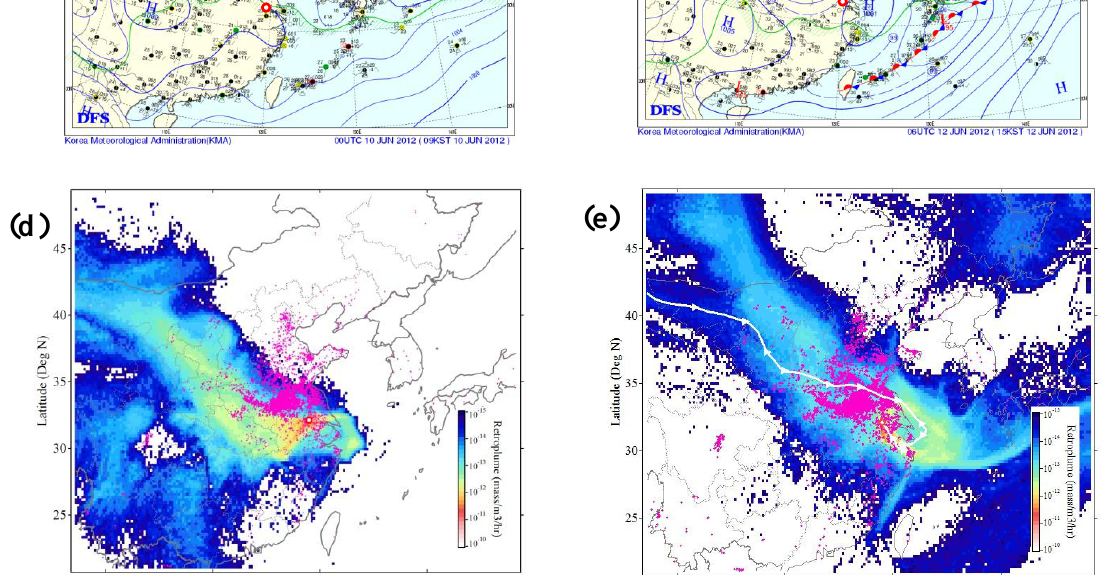
Figure 9. ( a ) Time series of O Fig. 9. (a) Time series of O 3 , PM 2 . 5 , related trace gases and meteorological parameters for Case III, i.e., 9–15 June, 2012; and weather charts for (b) 10 June 2011 and (c) 12 June 2011. (d) Averaged retroplumes for the periods marked with black boxes in (a) , and (e) with pink points Case III, i.e. 9-15 June, 2012. ( b ) and ( c ) Weather charts for 10 and 12 June 2011, 2 in (a) , give MODIS fire accounts for the period of 6–13 June 2012. White line with triangles given in (e) shows 7d backward trajectory for 15:00LT on 13 June respectively. ( d ) And ( e ) Averaged retroplumes for the periods marked with black boxs in 3 9( a ). Pink points give MODIS fire accounts for the period of 6-13 June 2012. White line with 4 triangles given in 9( e ) shows 7-day backward trajectory for 15:00 LT on 13 June 2012. 5